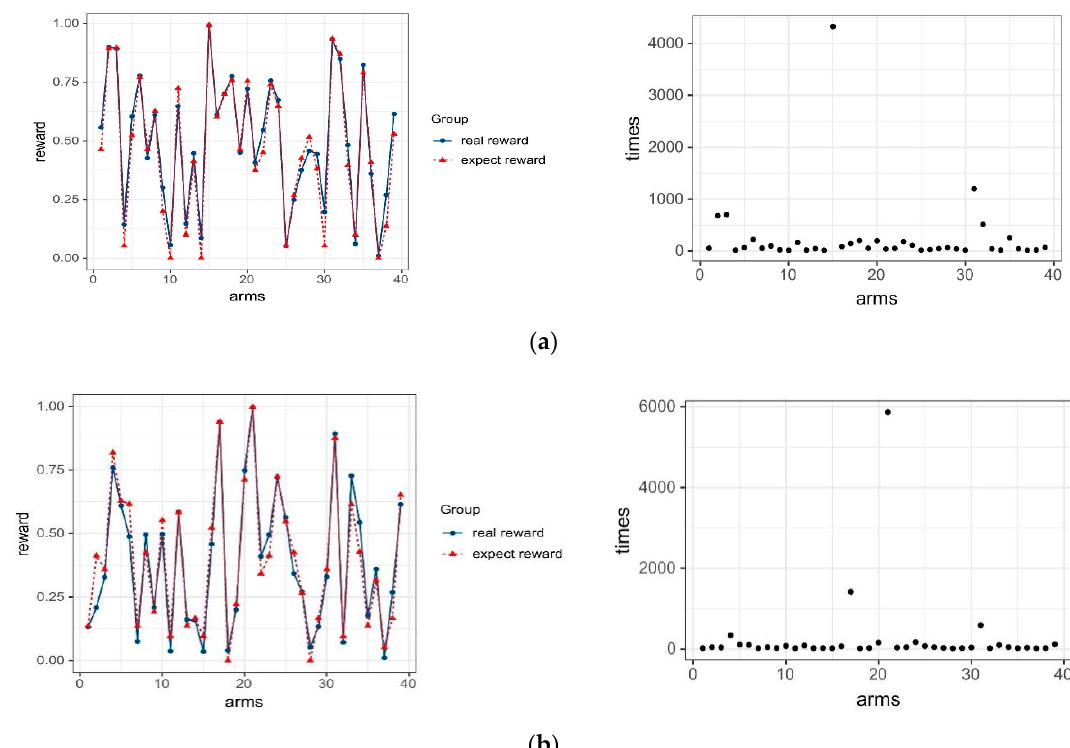
Figure 6. Left: reward prediction and right: arm selection when leakages occur in the ( a ) 15th and ( b ) 21st pipes. (On the left figure, the Y axis shows the reward for each pipe, and the X axis shows the number of pipes (i.e., the arm to be selected). The Y axis in the right figure represents the number of choices made by the agent, and the X axis represents the pipe to be selected.)